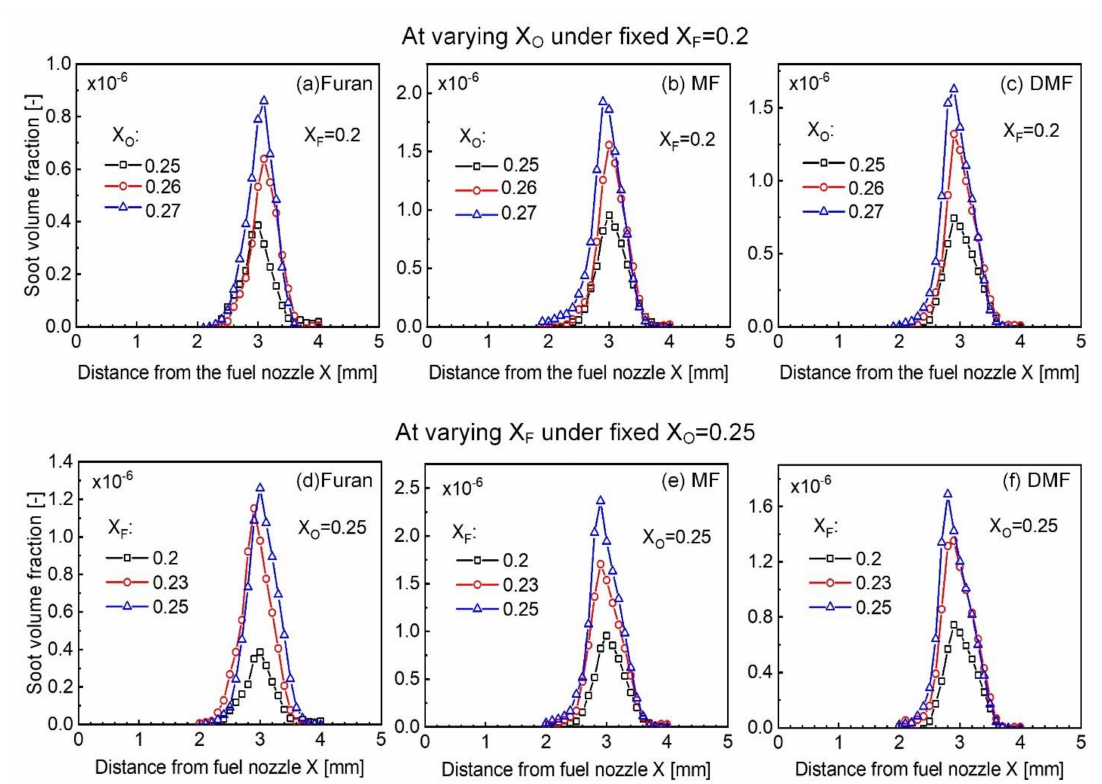
Figure 4. Measured profiles of the soot volume fraction for furan, MF, and DMF counterflow flames at a fixed X F = 0.2 under varying X O conditions ( upper panel ) and at a fixed X O = 0.25 under varying X F conditions ( lower panel